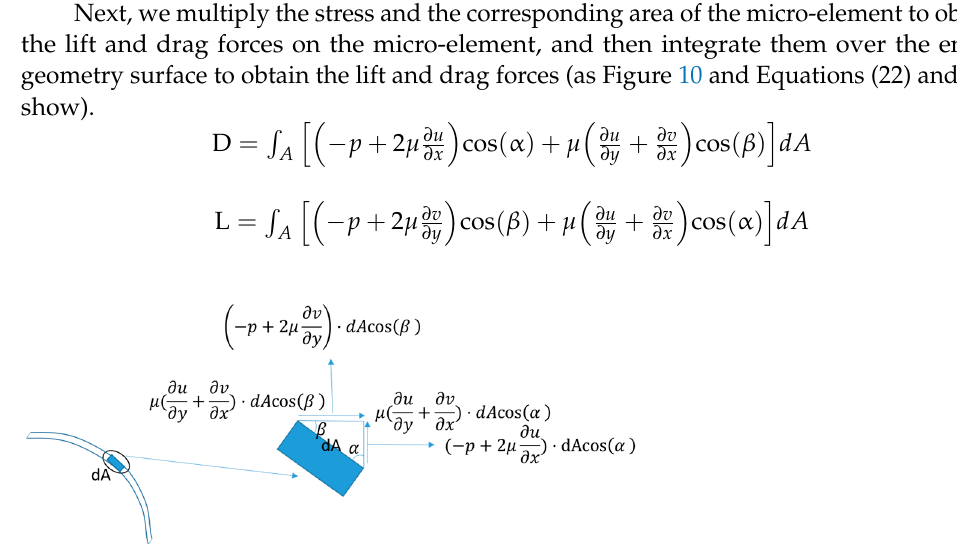
Figure 10. Lift and drag forces on